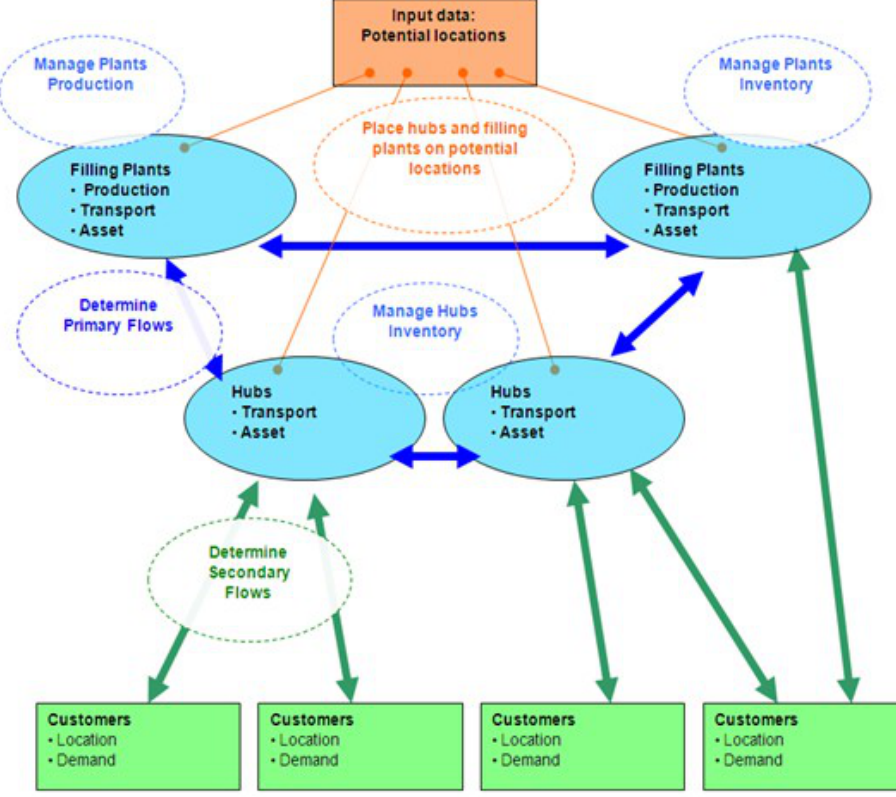
Figure 2. Network Design